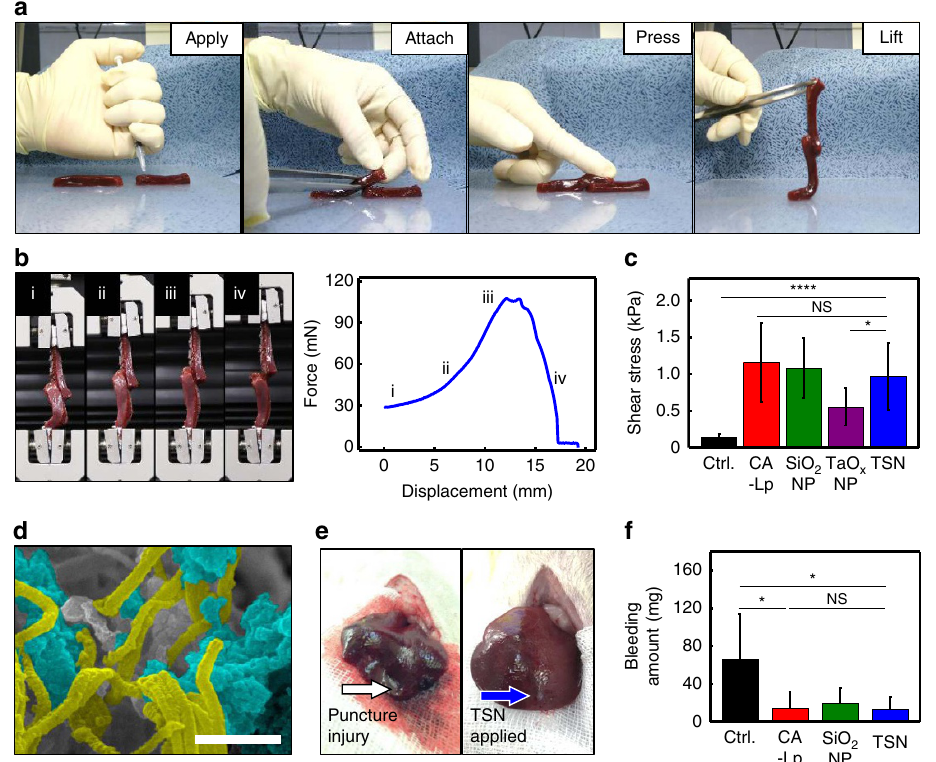
Figure 2 | Adhesion strength and hemostatic effect of TSNs in a liver puncture model. ( a ) Photographs showing the lap joint preparation procedure for analysing adhesive strength of various glues on biological tissues of two calf liver ribbons: applying the adhesive, attaching by overlapping the ribbons at the region where the adhesive was applied, gently pressing the ribbon for 30s, and lifting up and moving the joint to be analysed. ( b ) Photographs showing the lap joint shear test, and a representative force-displacement curve of the lap joint shear test of liver ribbons adhered by TSNs: (i) lifting the lower ribbon, (ii) loading the stress, (iii) ultimate stress point and failure, and (iv) sliding. ( c ) Adhesive shear stress of lap joint attached without glue (control) or with CA-Lp, SiO 2 NPs, TaO x NPs and TSNs. (Data are shown as mean ± s.d., n ¼ 9, * P o 0.05, **** P o 0.0001, and NS, not significant P 4 0.05, one-way ANOVA fiber are highlighted blue and yellow, respectively. Scale bar indicates 500nm. ( e ) Photographs of a stab wound after conducting each hemostasis procedure: direct pressure (left), applying TSNs (right). ( f ) Amount of bleeding during each hemostasis procedure. (Data are shown as mean ± s.d., n ¼